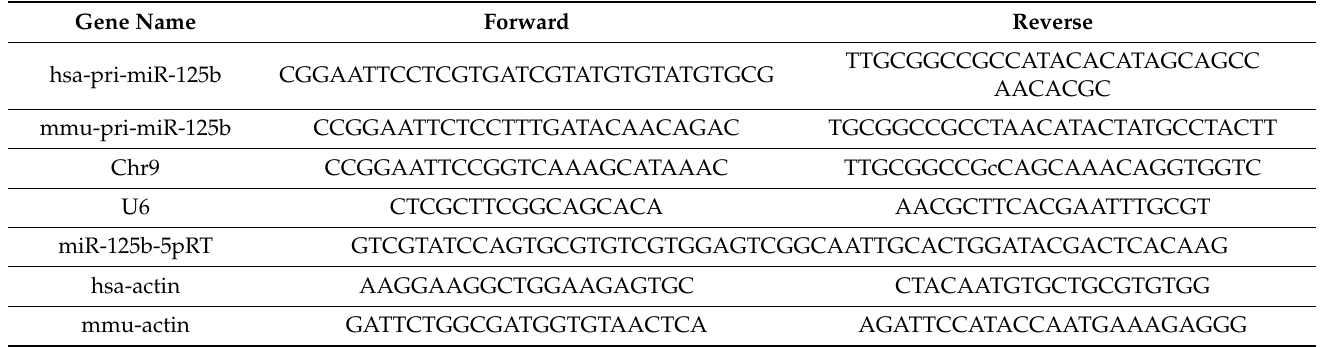
Table 1. List of primers used in the